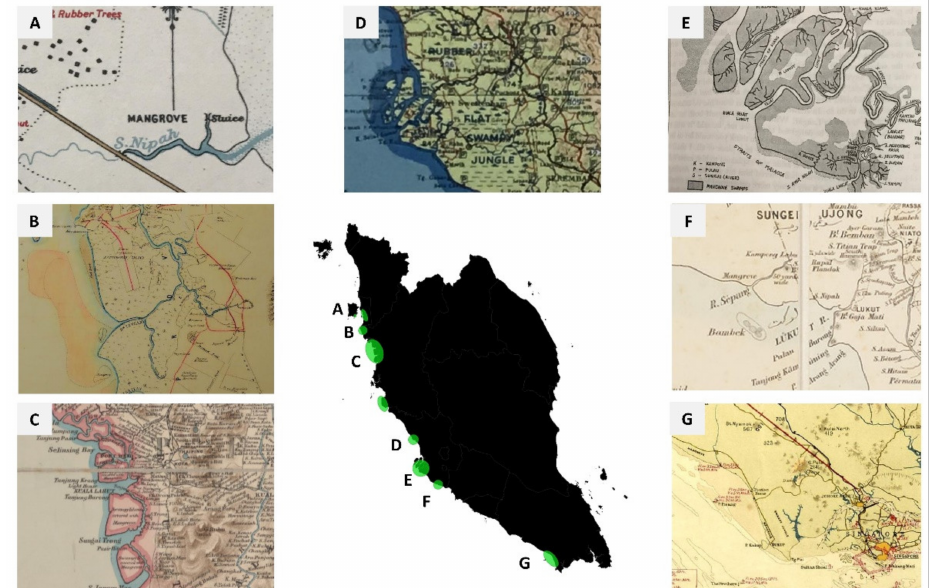
Figure 3. Base map of Peninsular Malaysia showing the locations of historical mentions of mangrove cover (areas in green labelled ( A – G ) denoted on the black map) with excerpts from corresponding historical maps surrounding the base map. Excerpt A: Map of Penang Aerodome—1932, (Acces- sion N ◦ CO 1047/957, National Archives of UK); Excerpt B: Map of Prince of Wales’ Island